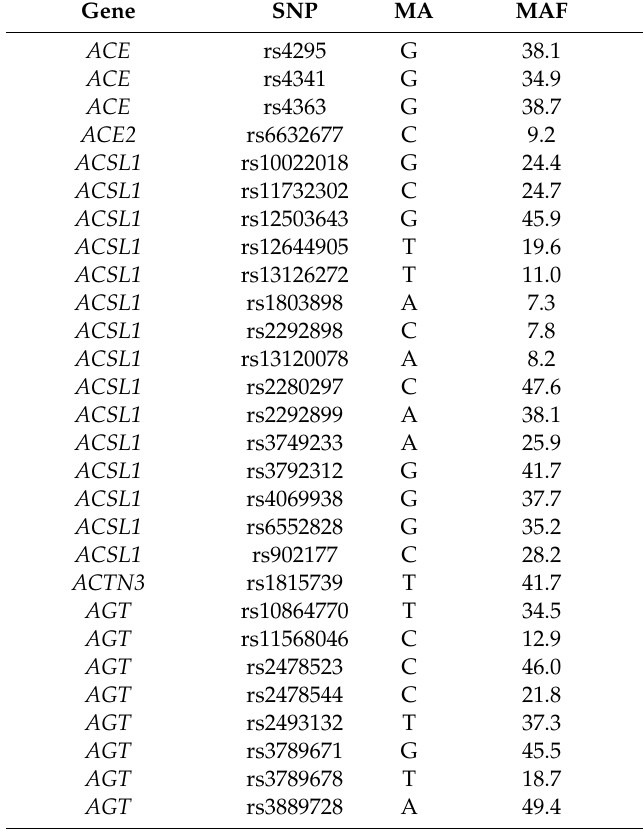
Table A1. List of SNPs investigated for association with VO 2peak (mL / kg / min) in Han Chinese untrained